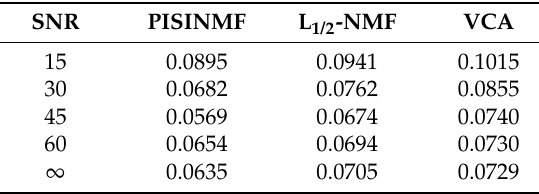
Table 4. RMSE comparison with different SNR.